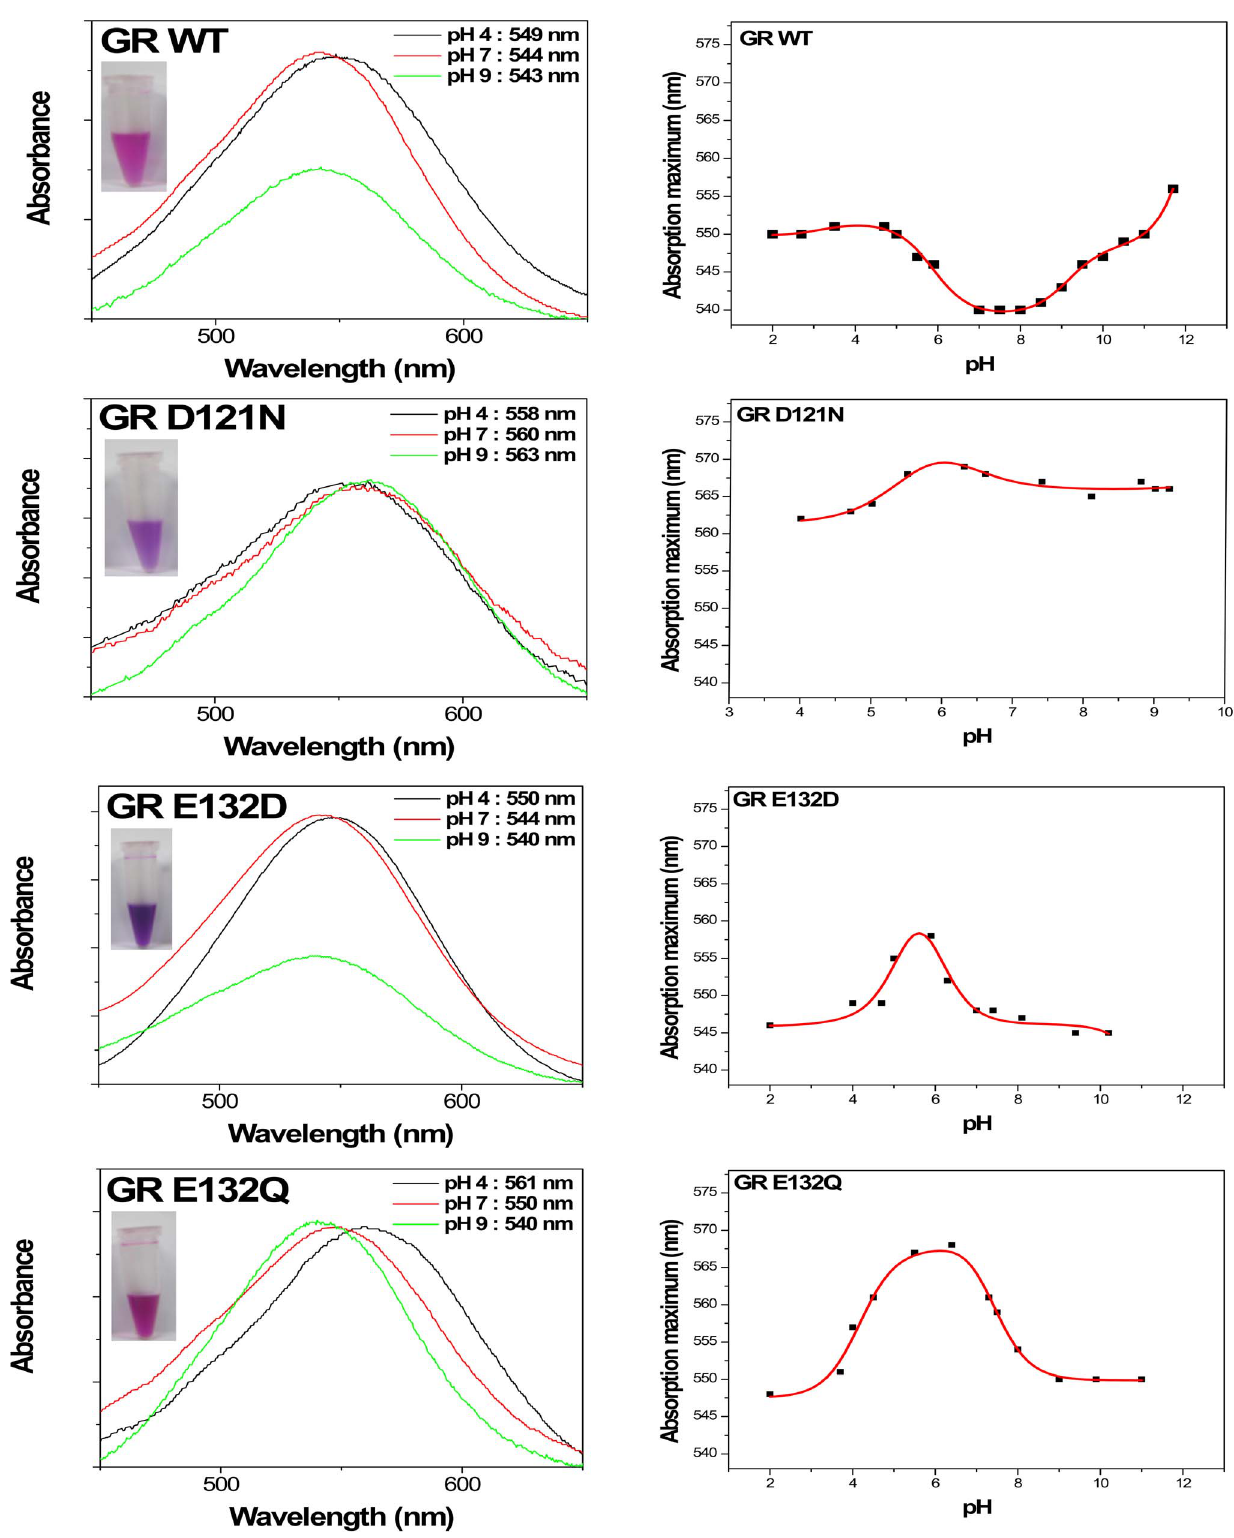
Figure 2. Absorption spectra and titration curves of GR and its mutants. Insets show photos of purified WT and mutant GR in 50 mM Tris (pH 7), 150 mM NaCl, and 0.02% DDM. The pH titration curves indicate the pH dependence of the absorption maxima of broad spectral range. The pK a values are shown in the table 1.